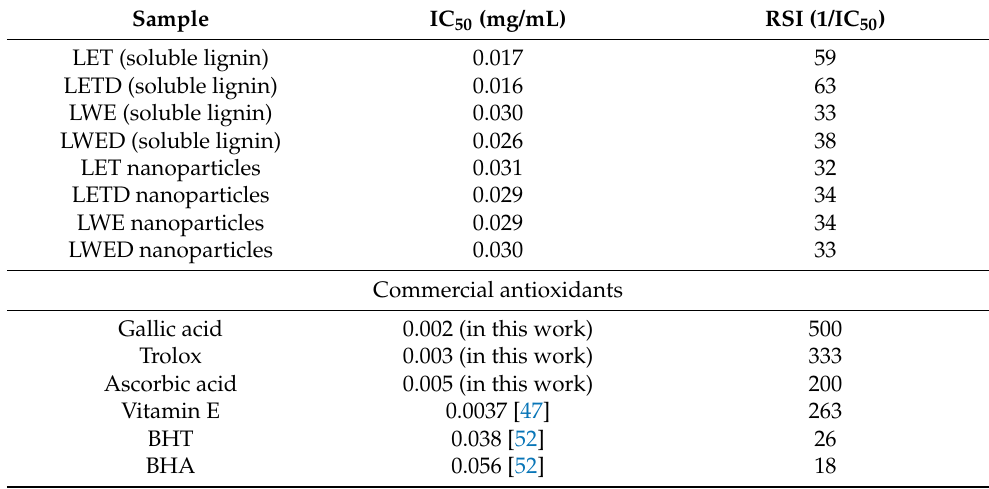
Table 3. IC 50 values of the lignin and nanoparticles from vine shoots were obtained in the current study with other antioxidants described in the literature. For comparison, RSI values were computed (=1/EC 50